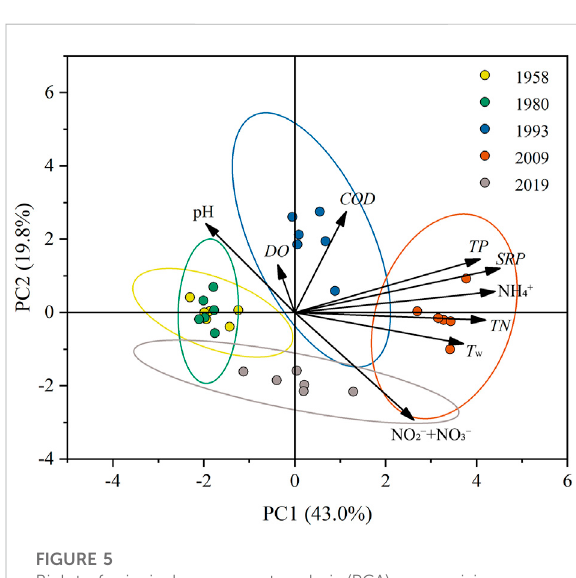
FIGURE 5 Biplot of principal component analysis (PCA) summarizing the variations in water quality factors of fi ve representative